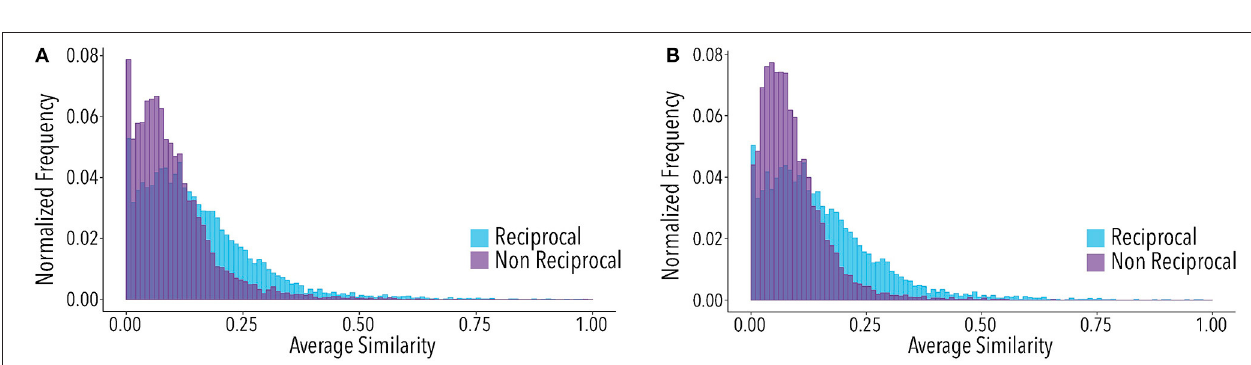
FIGURE 6 | (A) Distribution of average similarity between central users and reciprocal (blue) and non reciprocal (purple) followees. KS = 0.27, p < 0.001, MW = 0.66, p < 0.001. Medians of the distributions of reciprocal and of nonreciprocal relationships are 0.12 and 0.07, respectively. Distributions have been calculated considering only the 5,872 central users that have both reciprocal and non reciprocal followees in the dataset. (B) Distribution of average similarity between central users and reciprocal (blue) and non reciprocal (purple) mentions. KS = 0.22, p < 0.001, MW = 0.64, p < 0.001. The median similarity of the distribution of nonreciprocal mentions is 0.08 while for reciprocal mentions is 0.12. Distributions have been calculated considering only the 8,663 central users that have both reciprocal and non reciprocal mentions in the